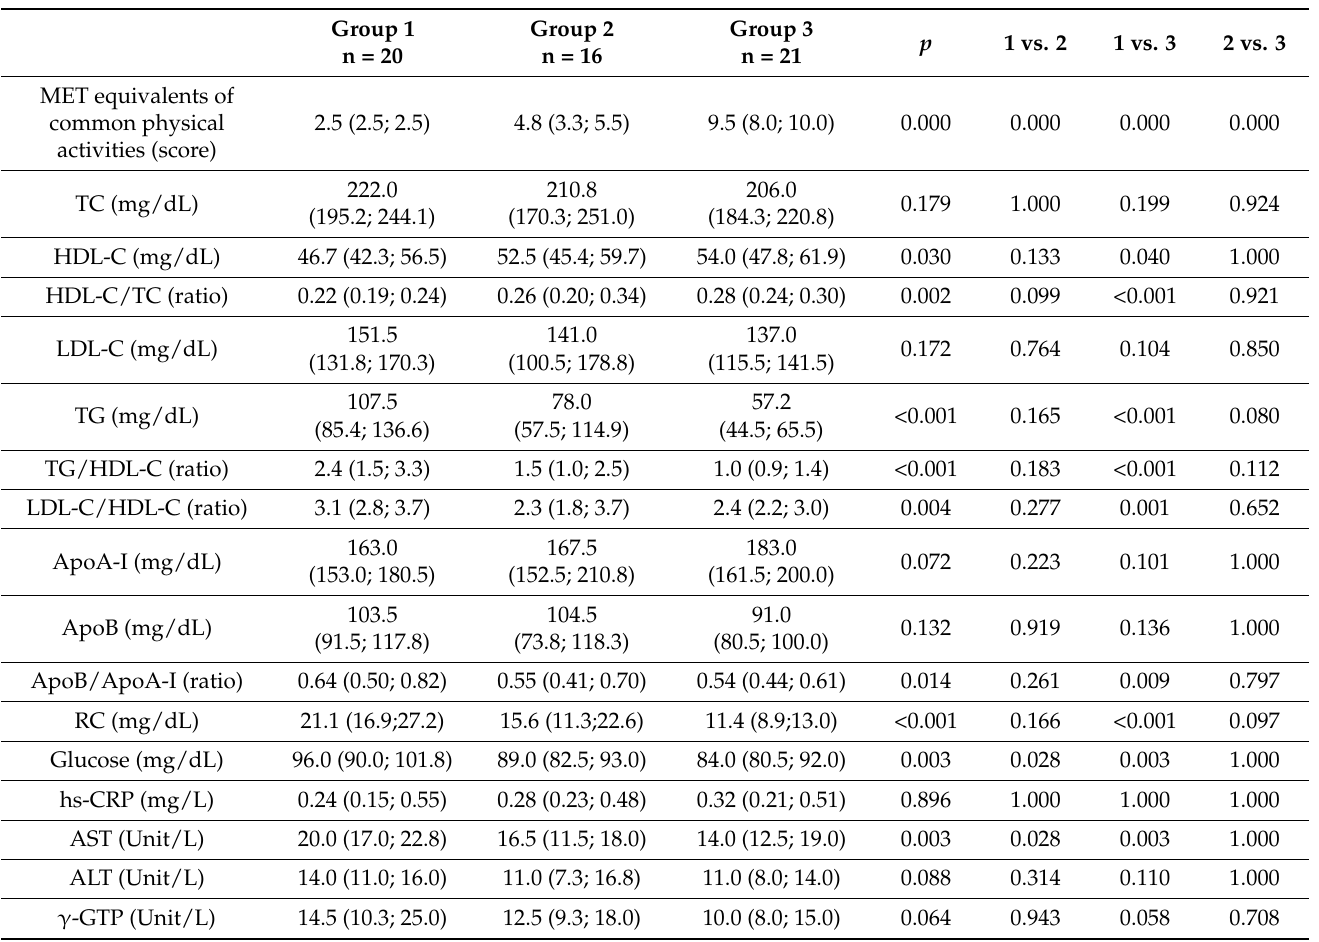
Table 2. Blood lipid and inflammatory parameters of women groups depending on exercise (Me (25%; 75%))